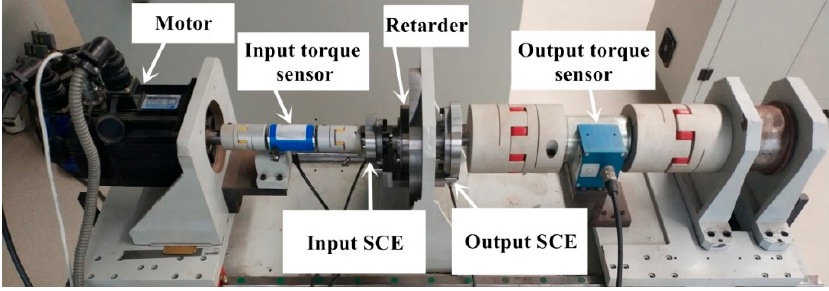
Figure 10. The test bench of precision speed reducer.